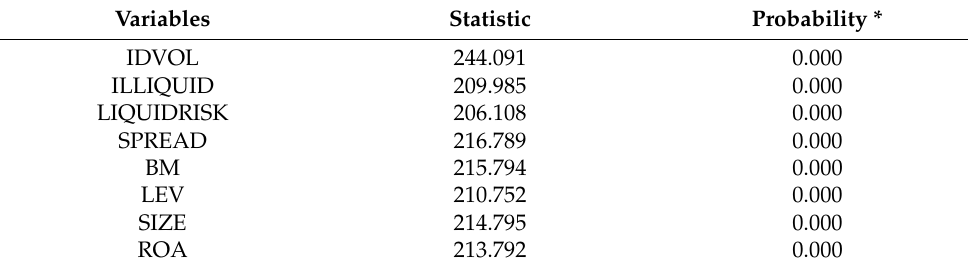
Table 4. The Stationarity Test (Root